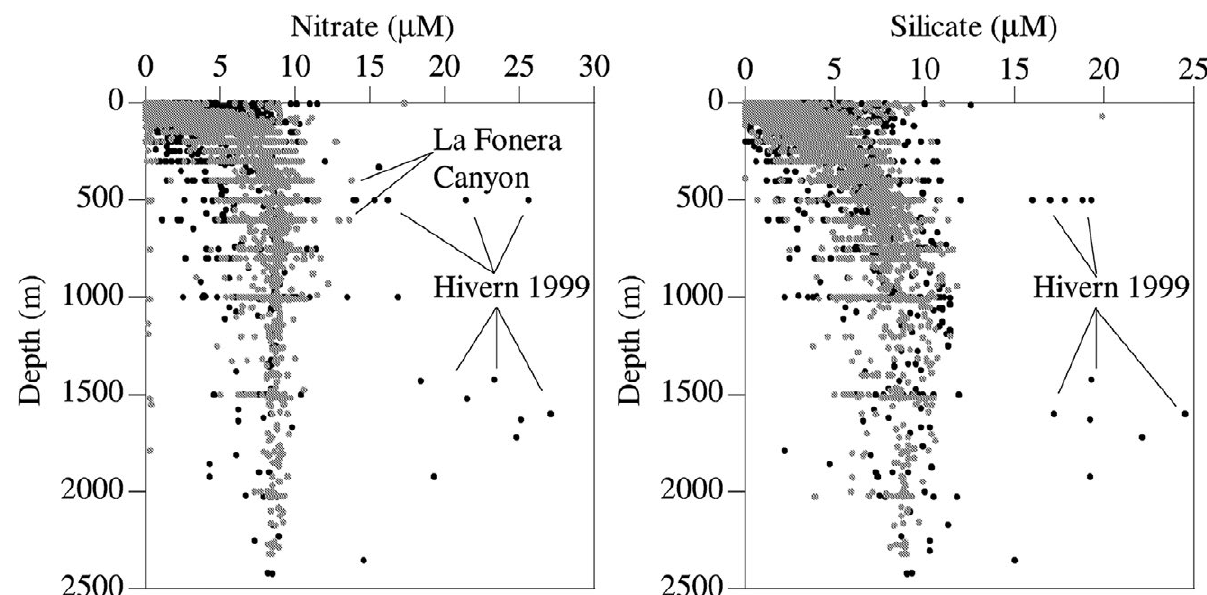
Fig. 9. – Scatter plots of nitrate and silicate vs. depth, including all the data collected. Black dots are from cruises in winter, and gray dots are from cruises between spring and autumn. High values are observed in mesopelagic and deep waters, corresponding to the Hivern cruise in 1999, a year of intense deep shelf water cascading in the Cap de Creus Canyon, as well as inside the La Fonera Canyon (south of the Cap the Creus Canyon) in